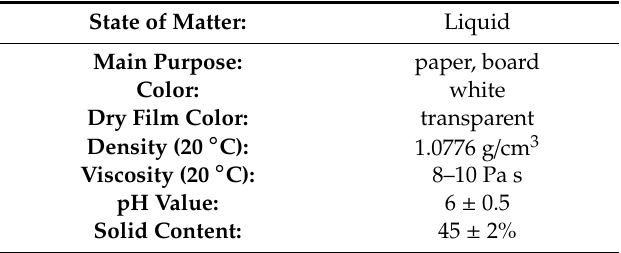
Table 1. Properties of Signokol L adhesive given by the producer